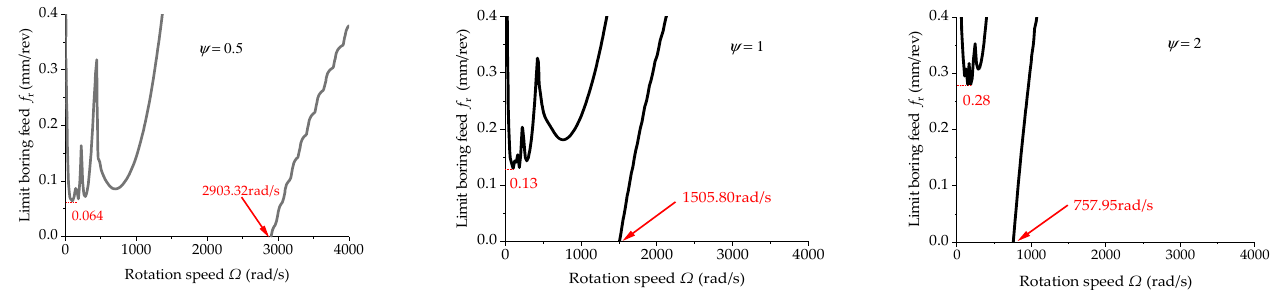
Figure 15. Effect of the change in internal damping on the stability ( L = 2 m and TR = 1).